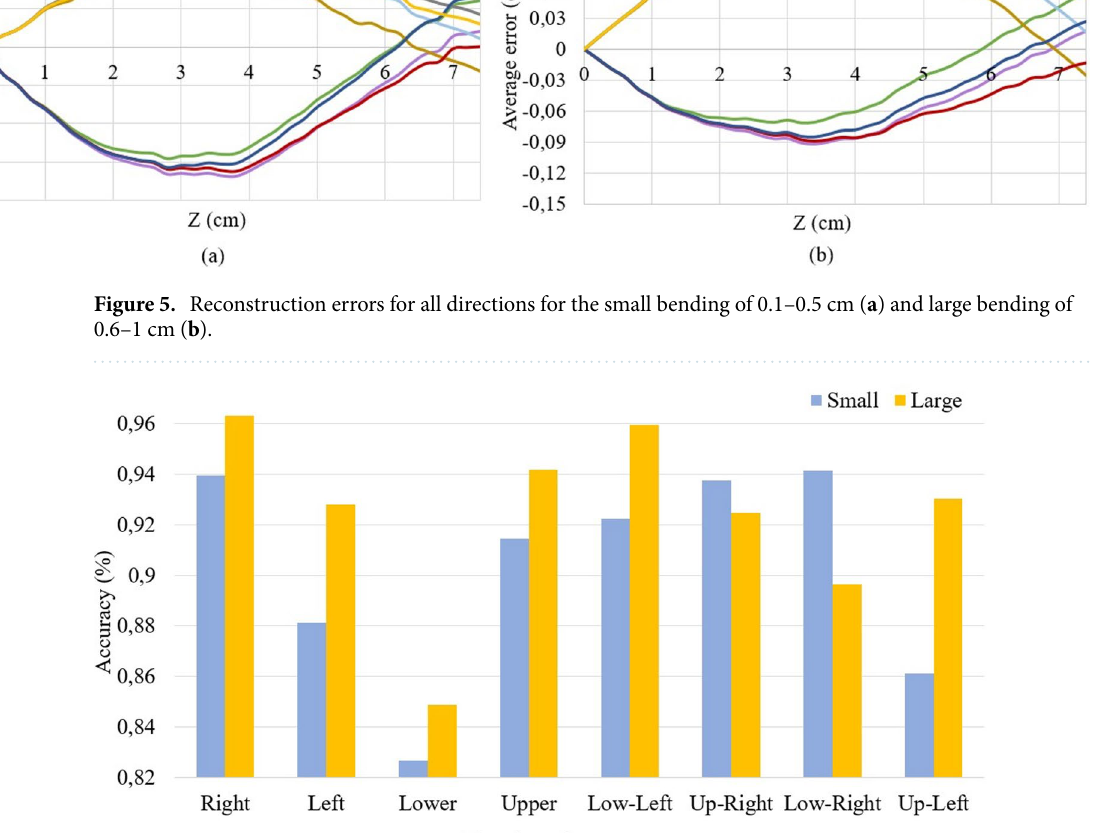
Figure 6. Accuracy of the needle tip position identification for small bending of 0.1–0.5 cm and large bending of 0.6–1